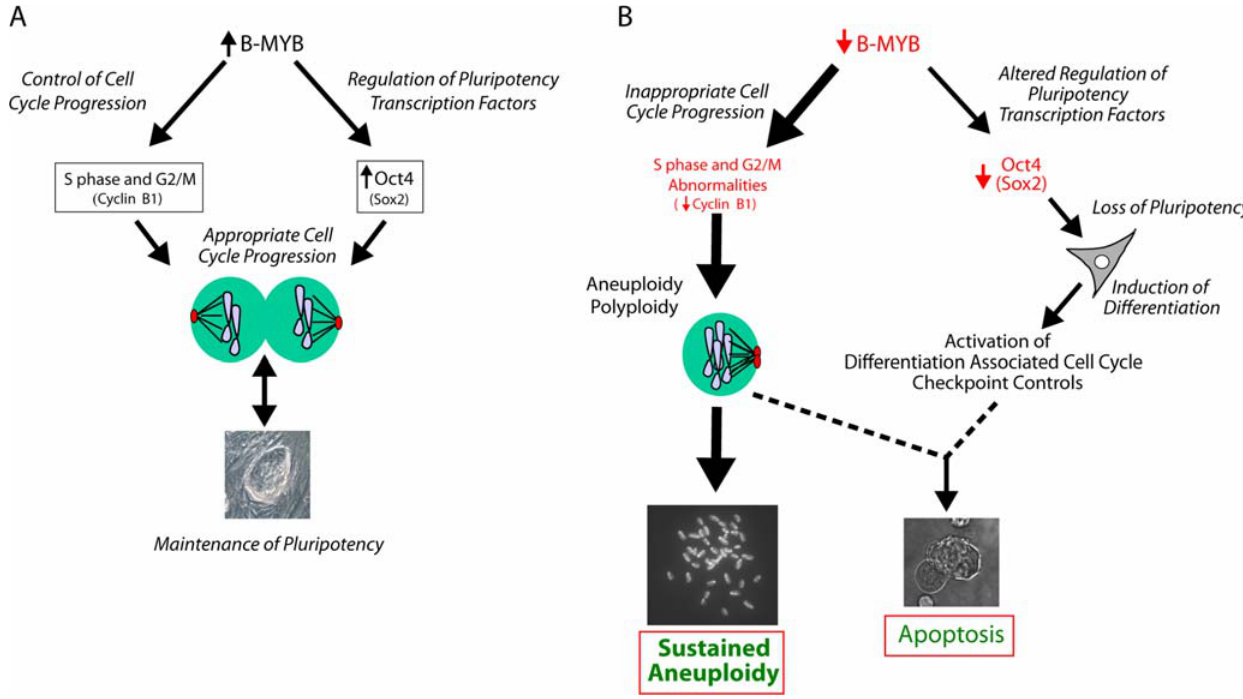
Figure 7. Proposed functions of B-Myb in ES cells. A) Under normal conditions, high levels of endogenous B-Myb promote proliferation through coordination of events in S phase and appropriate transit through G2/M. It also modulates Oct4 expression to help maintain the undifferentiated and pluripotent state of ES cells. B) The primary effect of reduced levels of B-Myb is the generation of polyploid and aneuploid cells due to a loss of normal cell cycle progression through G2/M and spindle defects. Loss of B-Myb also causes a reduction in Oct4 expression and ES cell differentiation. Because differentiated cells have tight checkpoint controls that are capable of recognizing chromosomal abnormalities and activating apoptosis, this may represent a control mechanism necessary to maintain chromosome fidelity during early embryo development. Many of the surviving mES cells that were transiently deficient in B-Myb do not undergo apoptosis. Instead some of these cells become aneuploid, and can no longer be considered as authentic ES cells. Gene products in parentheses represent additional but putative targets of B-Myb